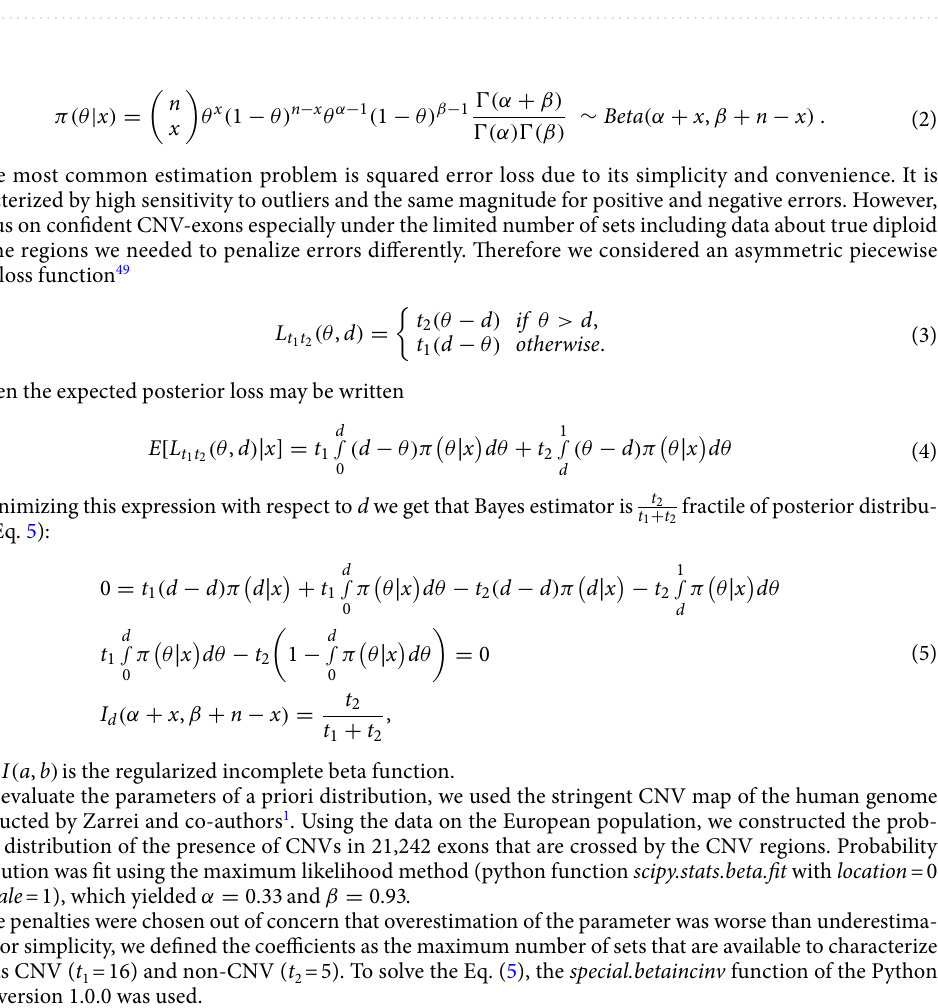
Figure 2. Distribution of the probability estimation. Threshold for exon classification is indicated by a dotted